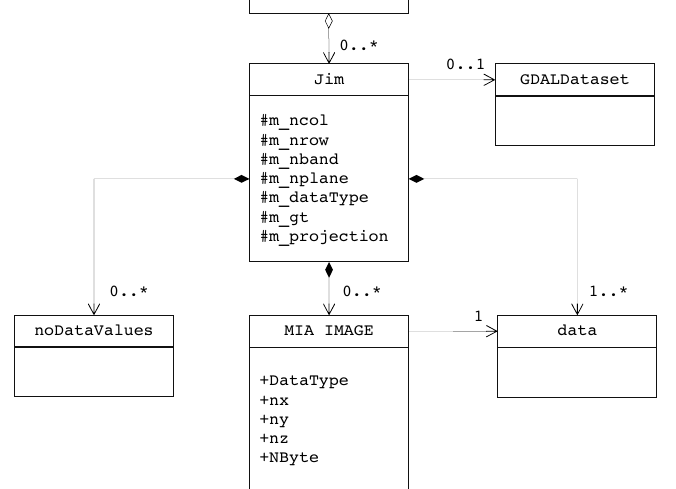
Figure 1. Class diagram for raster datasets.